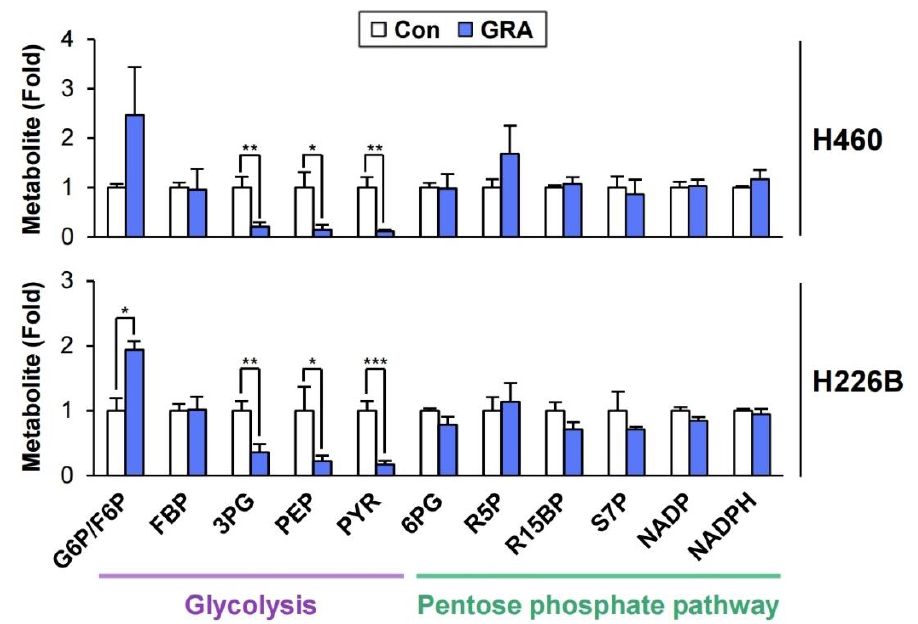
Figure 1. Modulation of glycolysis-associated metabolites by treatment with gracillin. H460 and H226B cells were treated with gracillin for 8 h. Cellular metabolic profiles associated with glycolysis and the pentose phosphate pathway were determined by LC / MS analysis. The bars represent the mean ± SD; * p < 0.05, ** p < 0.01, and *** p < 0.001, as determined by a two-tailed Student’s t -test by comparison with the vehicle-treated control group. Con: control; GRA: gracillin; G6P / F6P: glucose-6-phosphate / fructose-6-phosphate; FBP: fructose-1,6-bisphosphate; 3PG: 3-phosphoglycerate; PEP: phosphoenolpyruvate; PYR: pyruvate; 6PG: 6-phosphogluconate; R5P: ribulose-5-phosphate; R15BP: ribose-1,5-bisphosphate; S7P: sedoheptulose-7-phosphate; NADP: nicotinamide adenine dinucleotide phosphate; NADPH: reduced nicotinamide adenine dinucleotide phosphate.